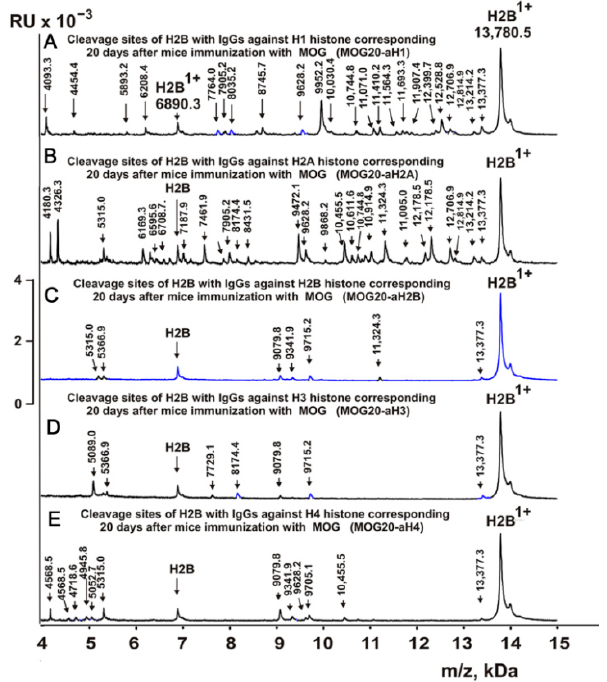
Figure 3. MALDI spectra corresponding to products of H2B histone (0.9 mg/mL) hydrolysis in the presence of IgGs (0.04 mg/mL) against two histones corresponding to zero time and after spontaneous development of EAE during 60 days: Con-aH3-0d ( A ), Spont-aH3-60d ( B ), Con-aH4-0d ( C ), and Spont-aH4-60d ( D ). All designations of IgG preparations and values of m/z are shown in the figure.